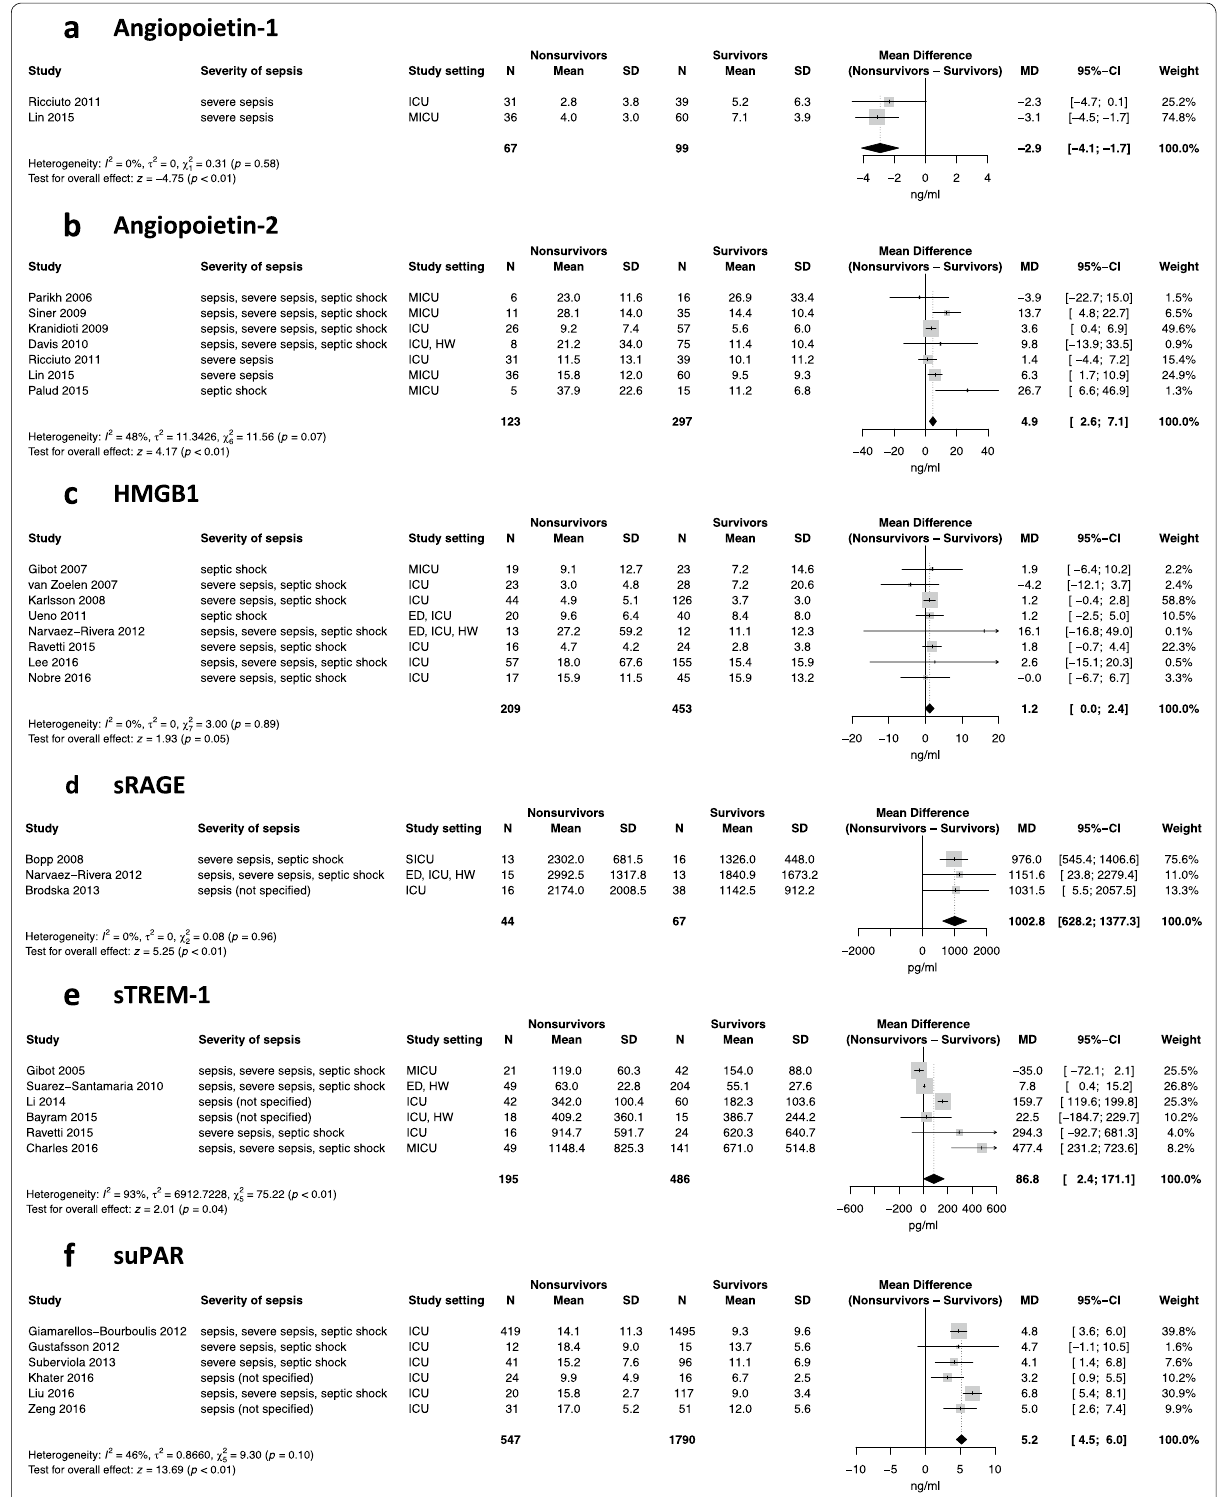
Fig. 2 Forest plots of pooled mean differences in biomarker concentration (nonsurvivors higher biomarker concentrations in survivors. Effect estimates to the right of 0 indicate higher biomarker concentrations in nonsurvivors. SD standard deviation, MD mean difference; setting of study: ED emergency department, ICU intensive care unit, MICU medical intensive care unit, SICU surgical intensive care unit, HW hospital